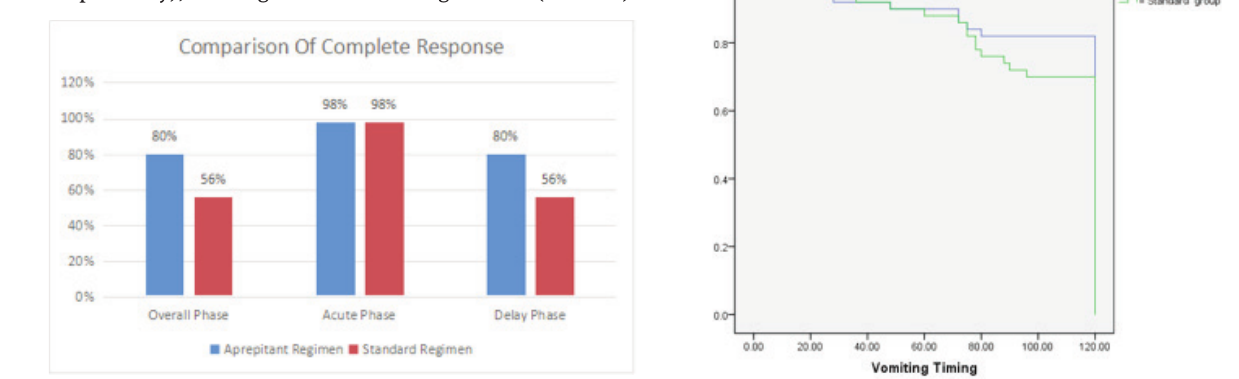
Figure 2: C omparison of time to first vomiting between the two